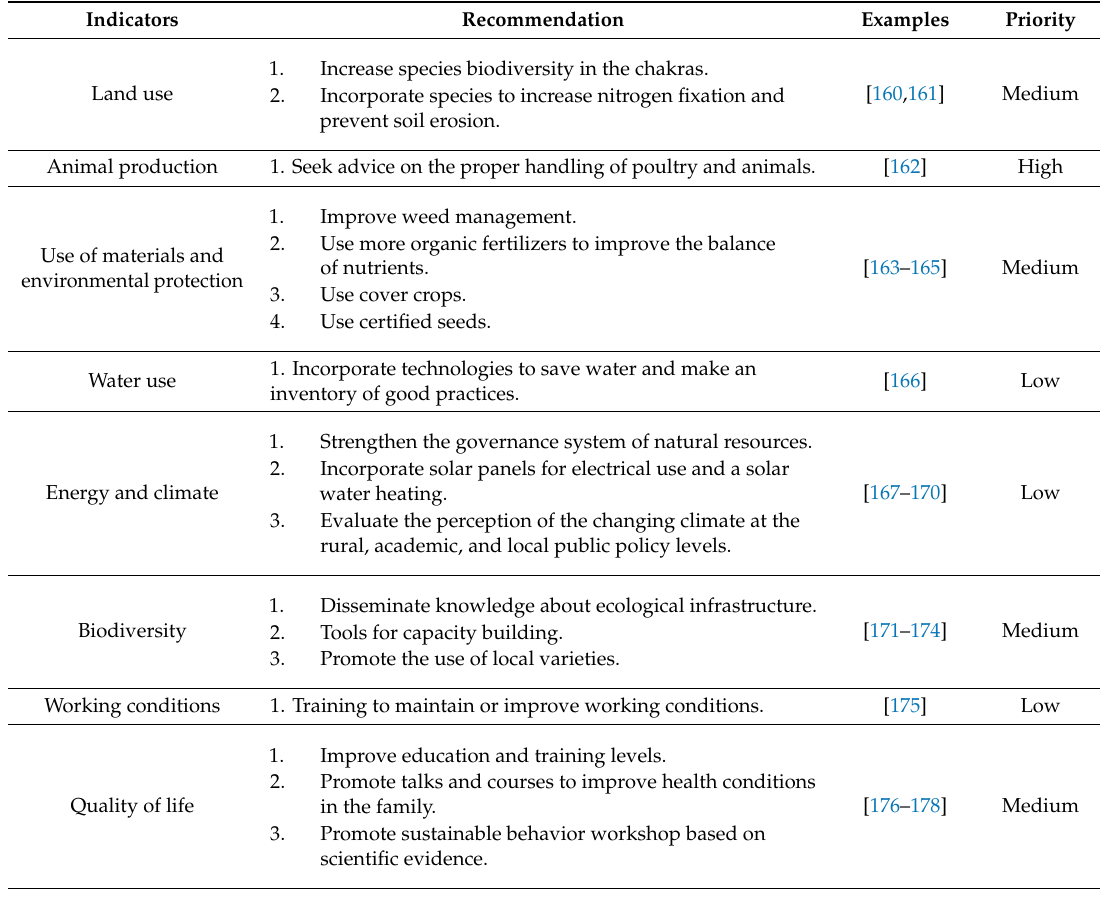
Table 6. Recommendations to strengthen the indicators resulting from the evaluation of sustainability.